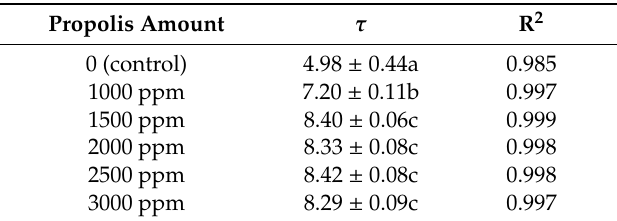
Table 3. F. oxysporum τ (time to attain a ½ of the maximum diameter) (day) on PDA + propolis (5–15%). Mean values ± standard error. R 2 , determination coefficient of Dantigny model. The letters indicate significant differences (one-way ANOVA and Tukey’s test, p < 0.05).